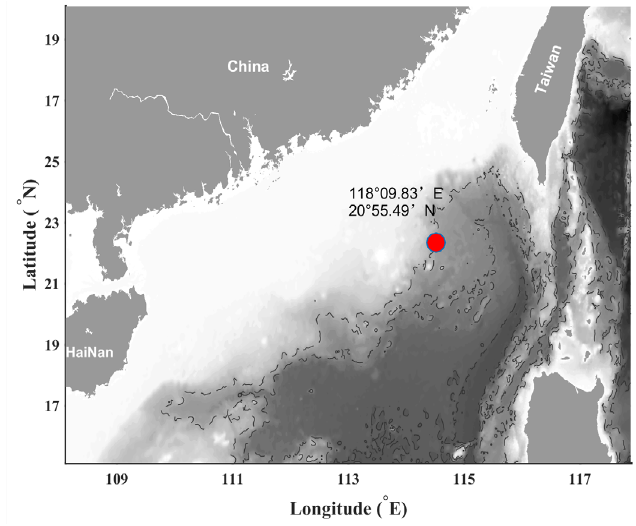
Figure 2. The field test location in the South China Sea.